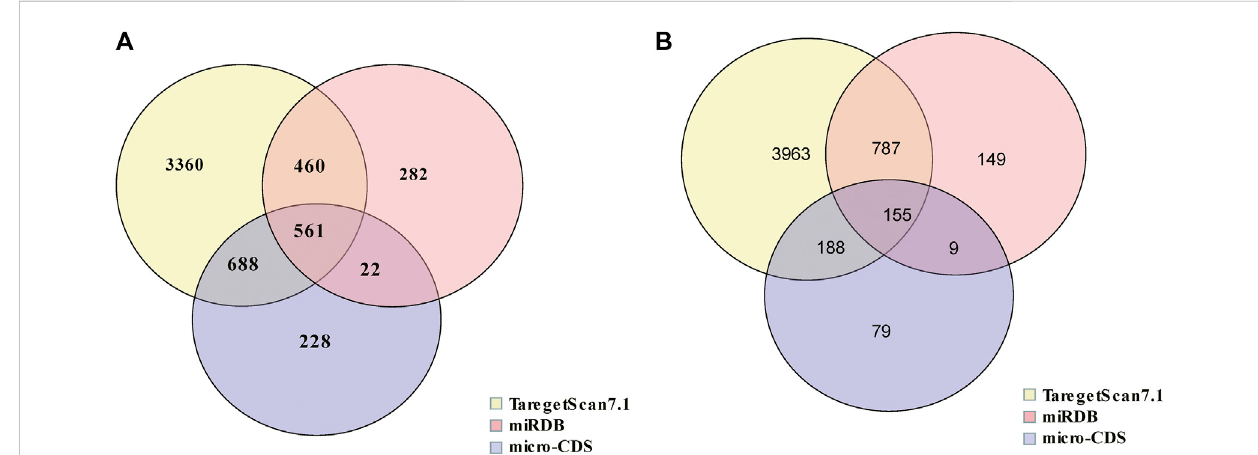
FIGURE 3 Venn diagram of target mRNAs of differential miRNAs. (A) The target mRNA prediction of upregulated miRNAs. (B) The target mRNA prediction of downregulated miRNAs.